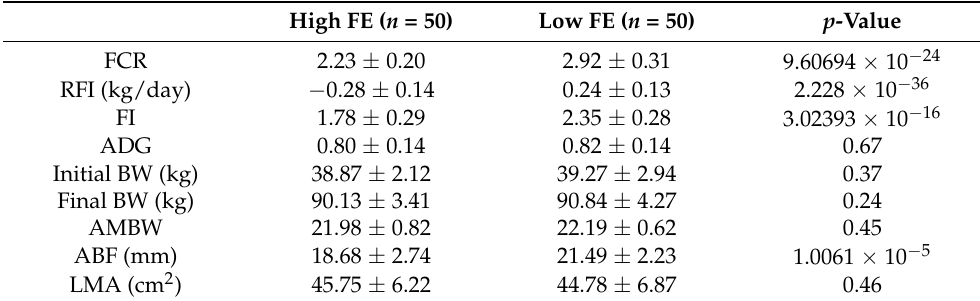
Figure 1. Summary of RFI in the populations of Yorkshire pigs. ( A ) The distribution of RFI in the populations of Yorkshire pigs. ( B ) The RFI of the sequencing individual. *** represent p ≤ 0.001, meaning the RFI between High-FE and Low-FE significant differences. Table 1. Animal performance of Yorkshire pigs with FE-extreme individuals.